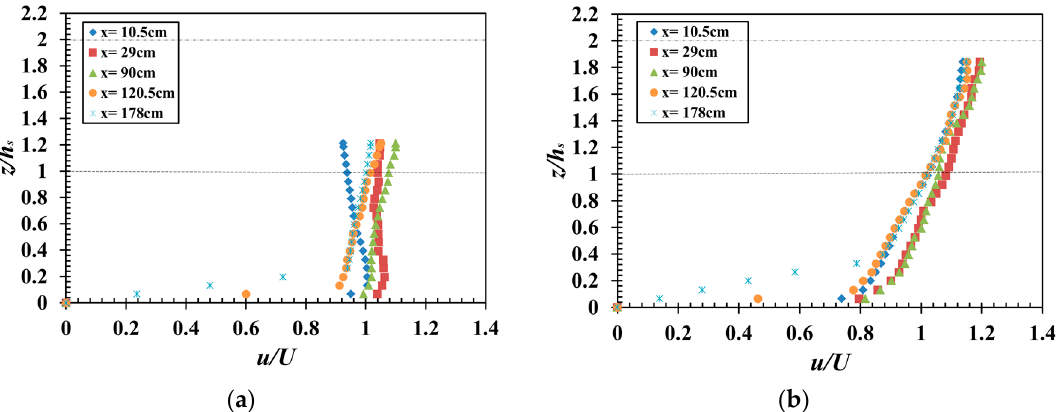
Figure 4. Vertical profiles of mean streamwise velocities at various locations of section y = 17.54 cm ( a ) for Case A, and ( b ) for Case B. For the meaning of x and y , see the caption of Figure 3.